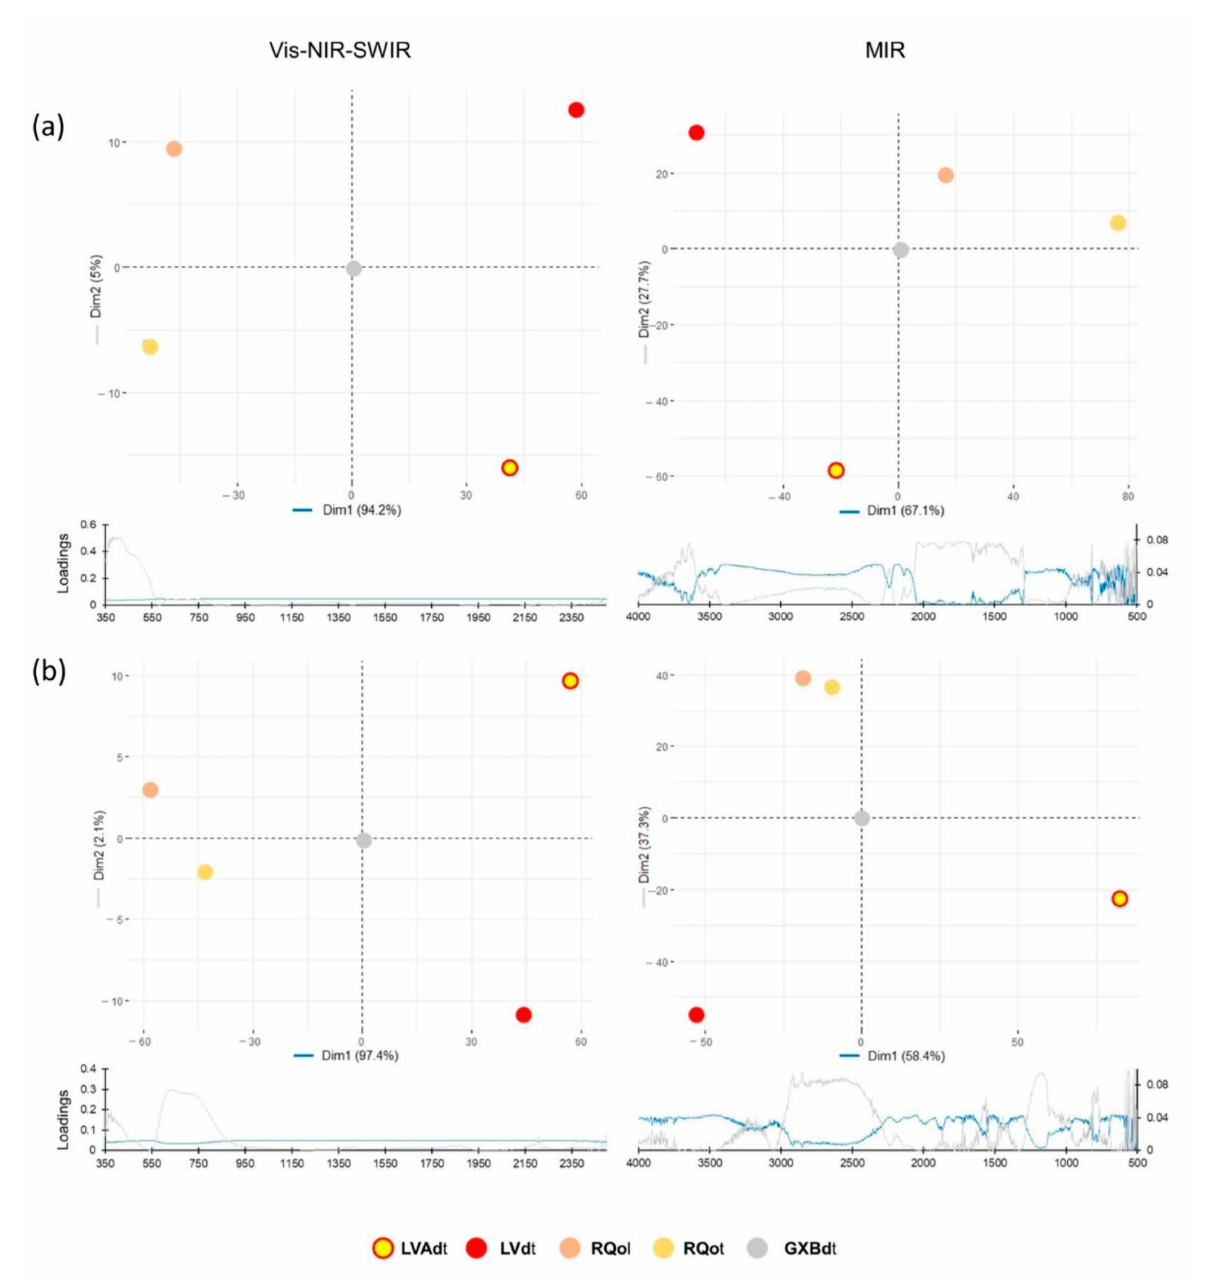
Figure 5. Principal Component Analysis (PCA) of representative profiles based on the VNS and MIR spectra of the surface ( a ) and subsurface ( b )